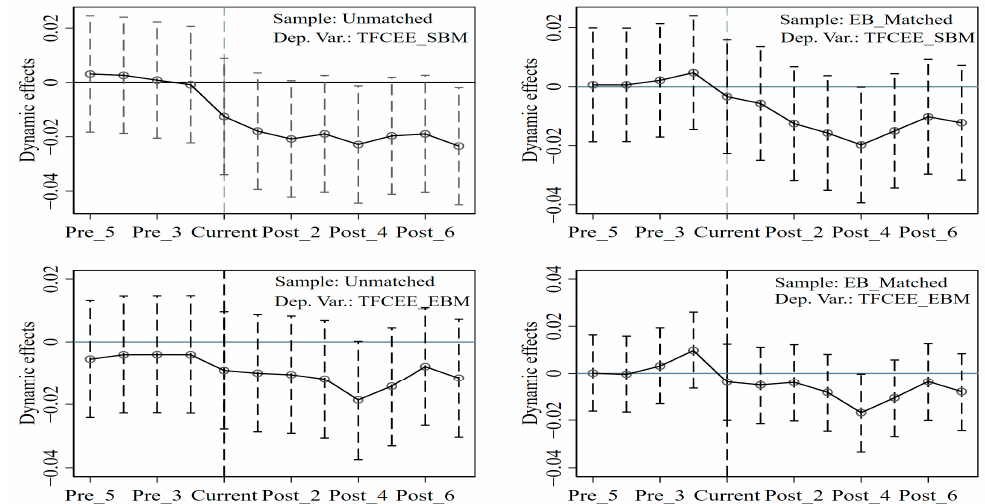
Figure 2. Results of the parallel trend test for the DID regression. Note: The figure is drawn using Stata 16.0.